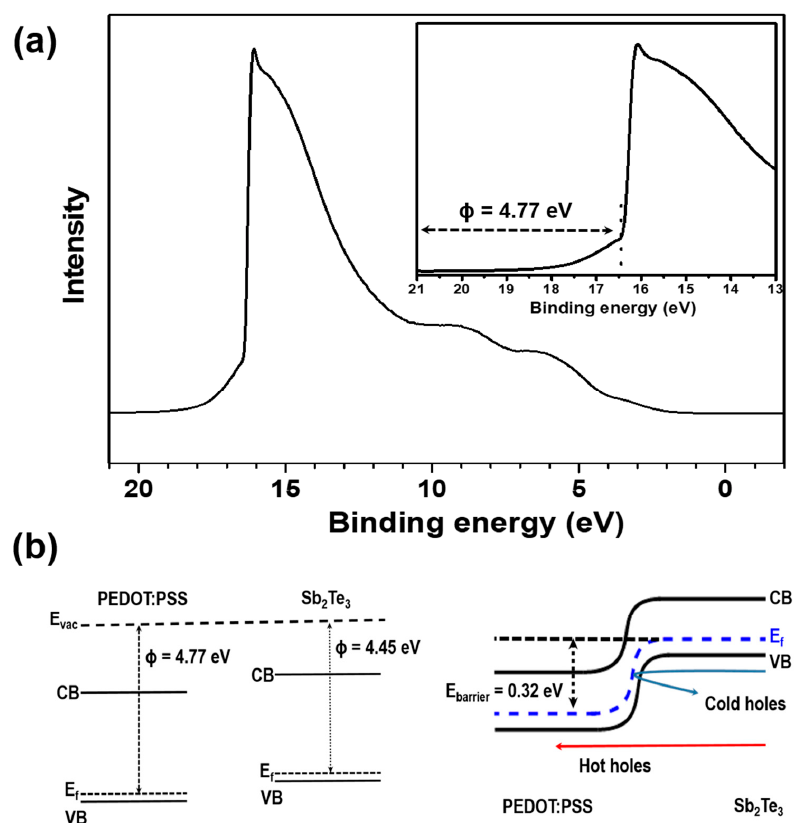
Figure 6. ( a ) UPS (ultraviolet photoelectron spectroscopy) spectrum of PEDOT:PSS-PVP nanofibers (the inset shows the calculated work function), and ( b ) band diagram at the interface between the Sb 2 Te 3 and PEDOT:PSS-PVP.